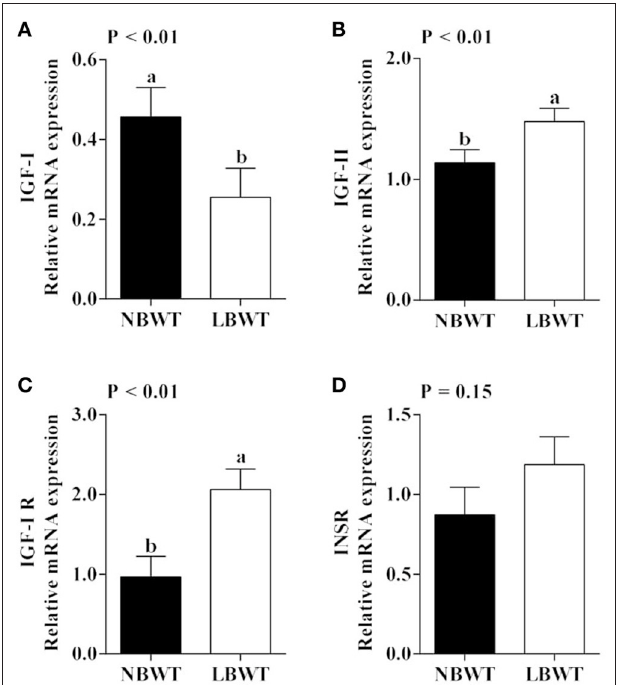
FIGURE 2 | Gene expression of insulin-like growth factor (IGF) system in longissimus dorsi muscle of low-birth-weight (LBWT) and normal-birth-weight (NBWT) neonatal pigs. (A – D) : Relative mRNA expression of IGF-I , IGF-II , IGF-I receptor ( IGF-I R) , and insulin receptor ( INSR) . Results are means ± SE. n = 12. Values with different letters differ significantly ( P ≤ 0.05).